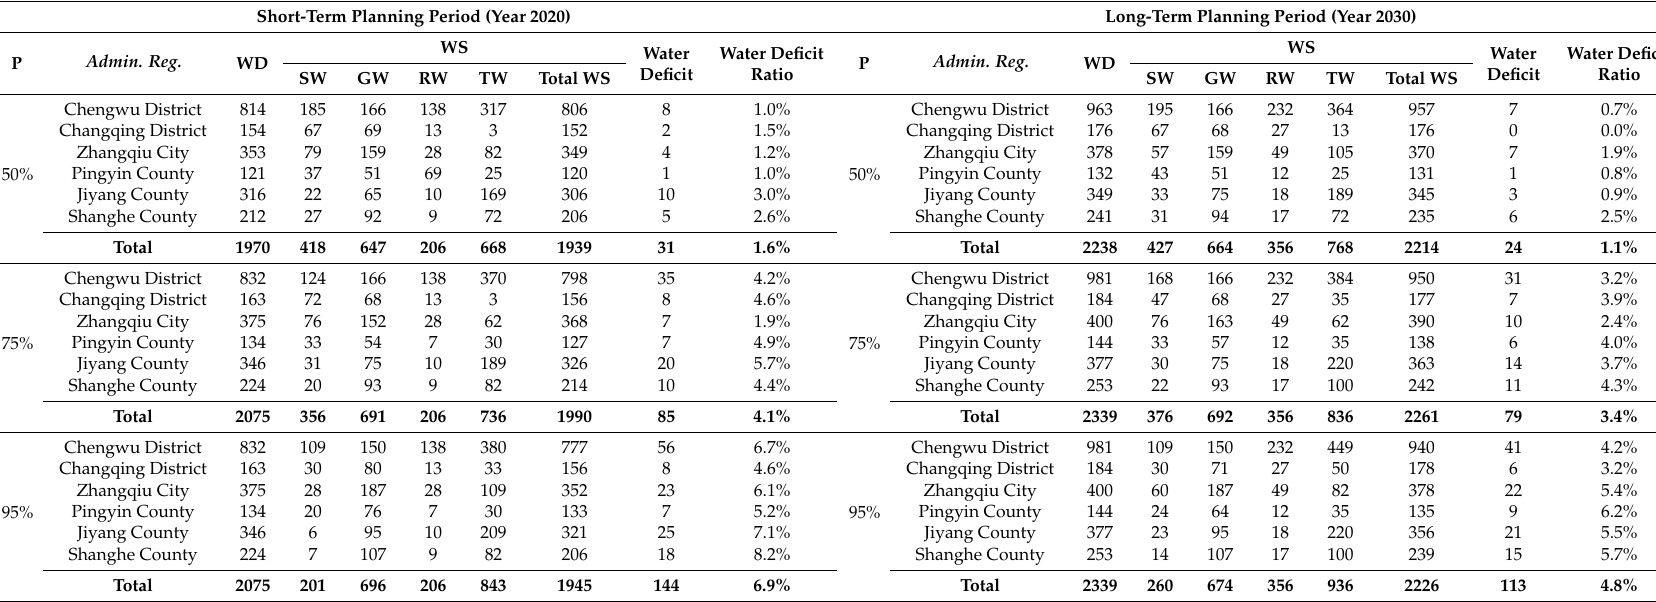
Table 7. Off-stream water balance between water supply and demand based on the multi-dimensional equilibrium allocation model (units: million m 3